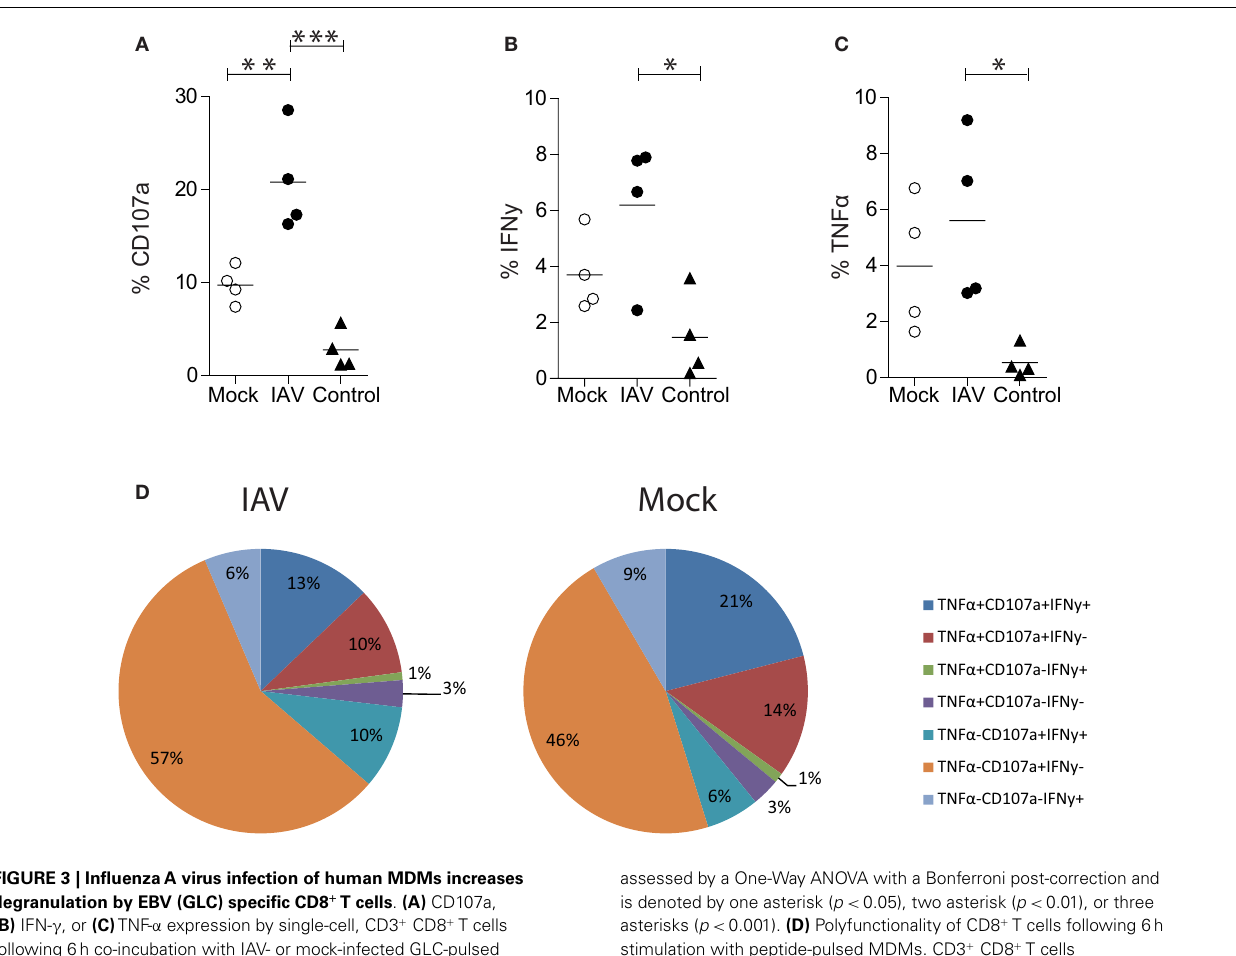
FIGURE 3 | InfluenzaA virus infection of human MDMs increases degranulation by EBV (GLC) specific CD8 + T cells . (A) CD107a, (B) IFN- γ , or (C) TNF- α expression by single-cell, CD3 + CD8 + T cells following 6h co-incubation with IAV- or mock-infected GLC-pulsed MDMs. Alternatively,T cells were incubated with MDMs pulsed with an irrelevant peptide (IP) derived from HCV (“control”). Data are pooled from four independent donors and statistical significance was